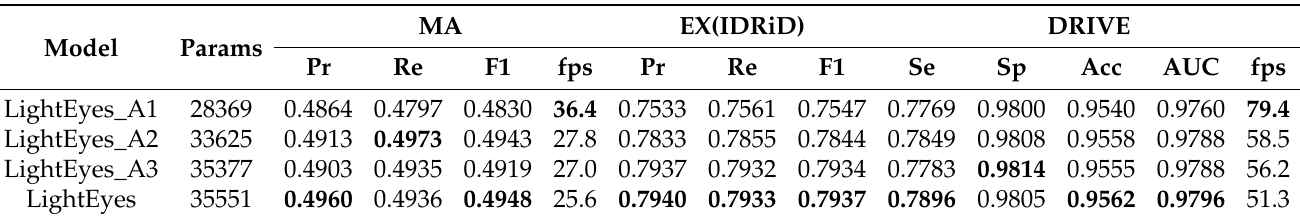
Table 14. Comparison of segmentation results and the number of parameters (Fps was measured under input with size 712 × 1072 and 584 × 565 on the IDRiD and DRIVE). Best results are bold.